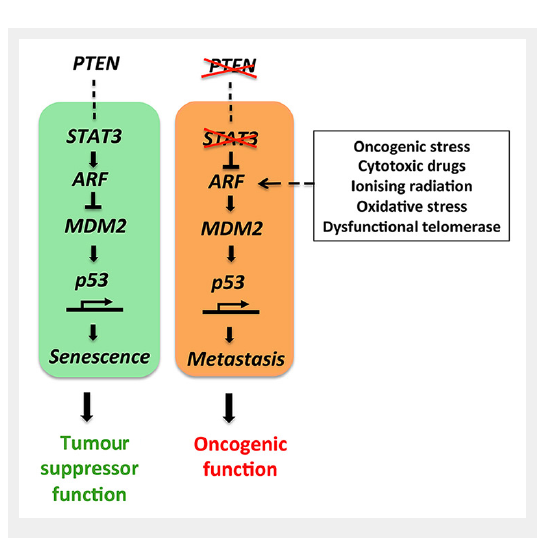
The STAT3-ARF tumour suppressor pathway is activated under normal conditions. Loss of PTEN and STAT3 function causes an oncogenic switch ultimately breaking the ARF-MDM2-p53 axis and inducing metastatic